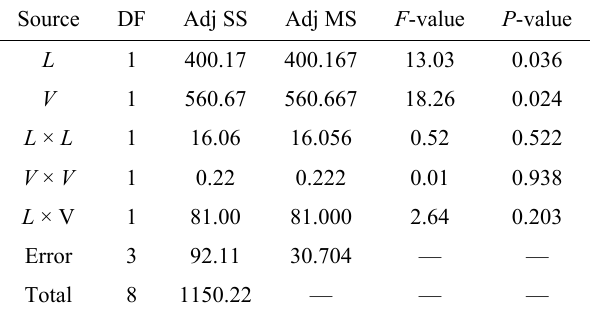
Table 7 Analysis of variance for S sc .